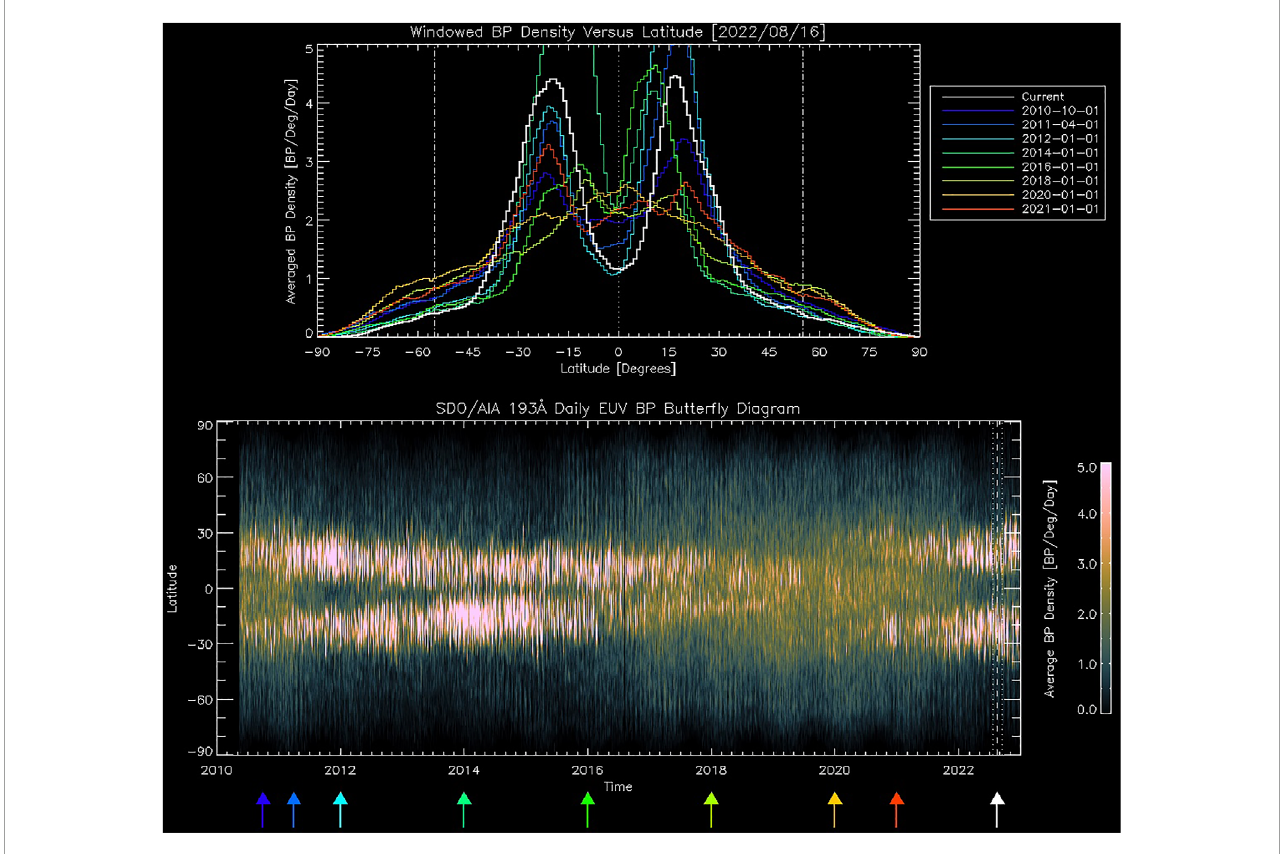
FIGURE 3 Comparing the latitudinal variation of EUV BPs since the start of the SDO mission (AIA 193Å; Figure 2B ) with a series of slices through latitude to show the variation of the BP distribution. Each colored line shown in the upper panel is averaged over 28 days and correspond to the same colored arrows shown in the lower panel. We note that the y -axis in the upper panel is truncated to permit easier comparison of the post-terminator state of the BP density in (2011 - blue/cyan) and (2021 - white). The online version of the Journal has an animation of this figure.